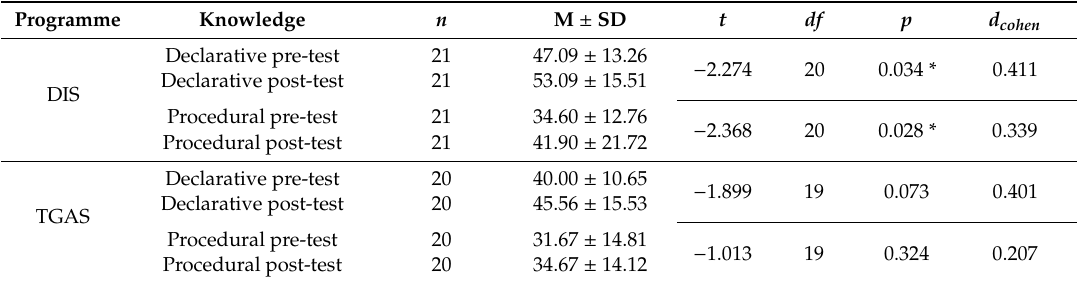
Table 5. Level of declarative and procedural knowledge acquired in each class group (pre-test / post-test).